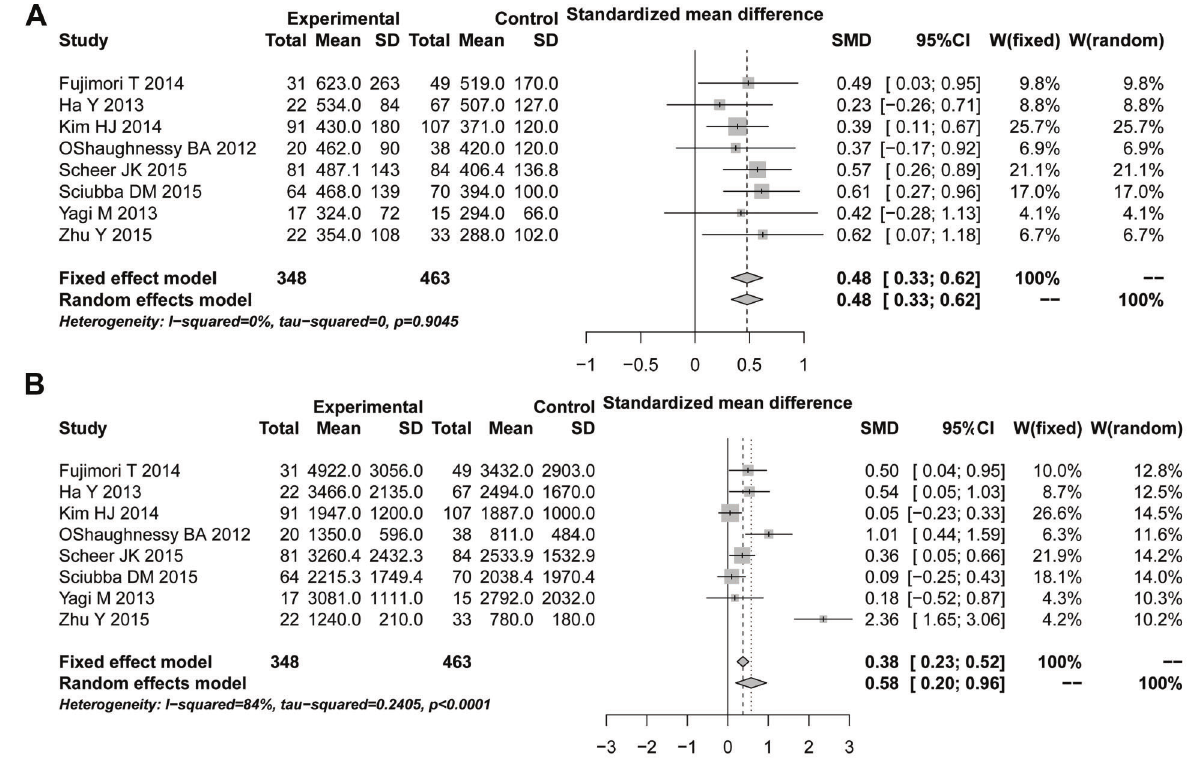
Figure 3. Forest plots for surgical outcome based on the of operating time ( A ) and blood loss (B ) outcomes. UT (experimental group): upper thoracic; LT (control group): lower thoracic. See Table 1 for reference numbers of cited